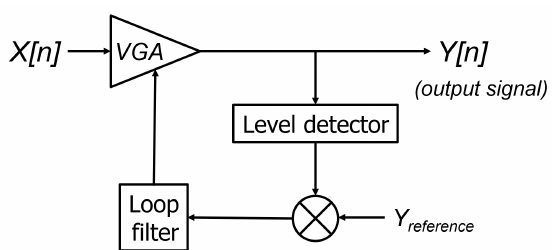
Figure 2. Schematic of a conventional Automatic Gain Controller (AGC).